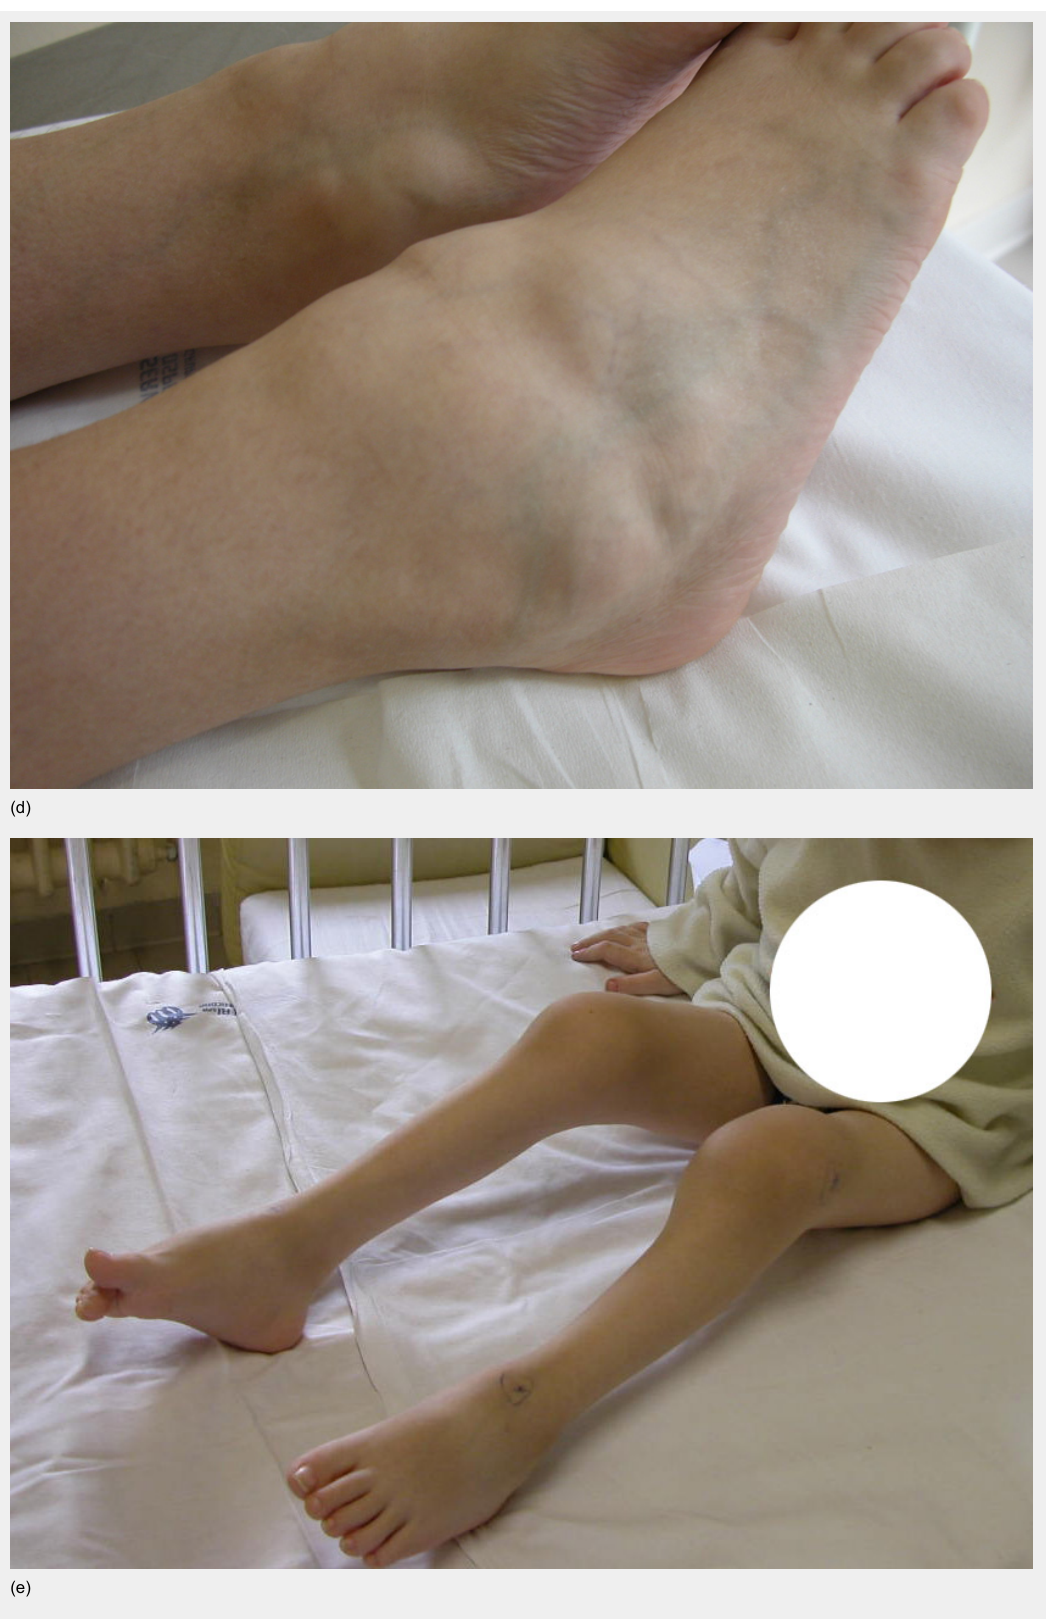
Figure 2 (a) Skin rash in a TRAPS patient; (b) Typical urticarial rash in a Muckle Wells patient carryng the D303N mutation; (c) Chronic papilloedema in a CINCA patient; (d) Typical boggy synovitis in a patient affected with Blau’s disease; (e) Bilateral pyogenic sterile arthritis of the knees in a 4-year-old patient with PAPA